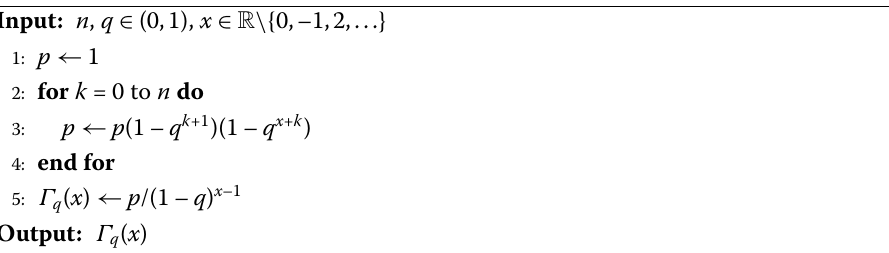
Algorithm 2 The proposed method for calculating Γ q ( x